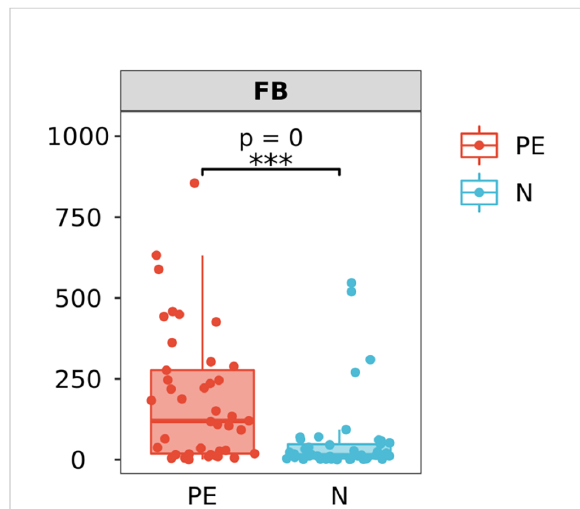
FIGURE 5 Varying ratios of Firmicutes and Bacteroidetes (F/B) at the phylum level between the two groups. F/B at the phylum level in the PE group is signi fi cantly higher than that in the normal group. PE, preeclampsia; N, the healthy normal group. *** P <